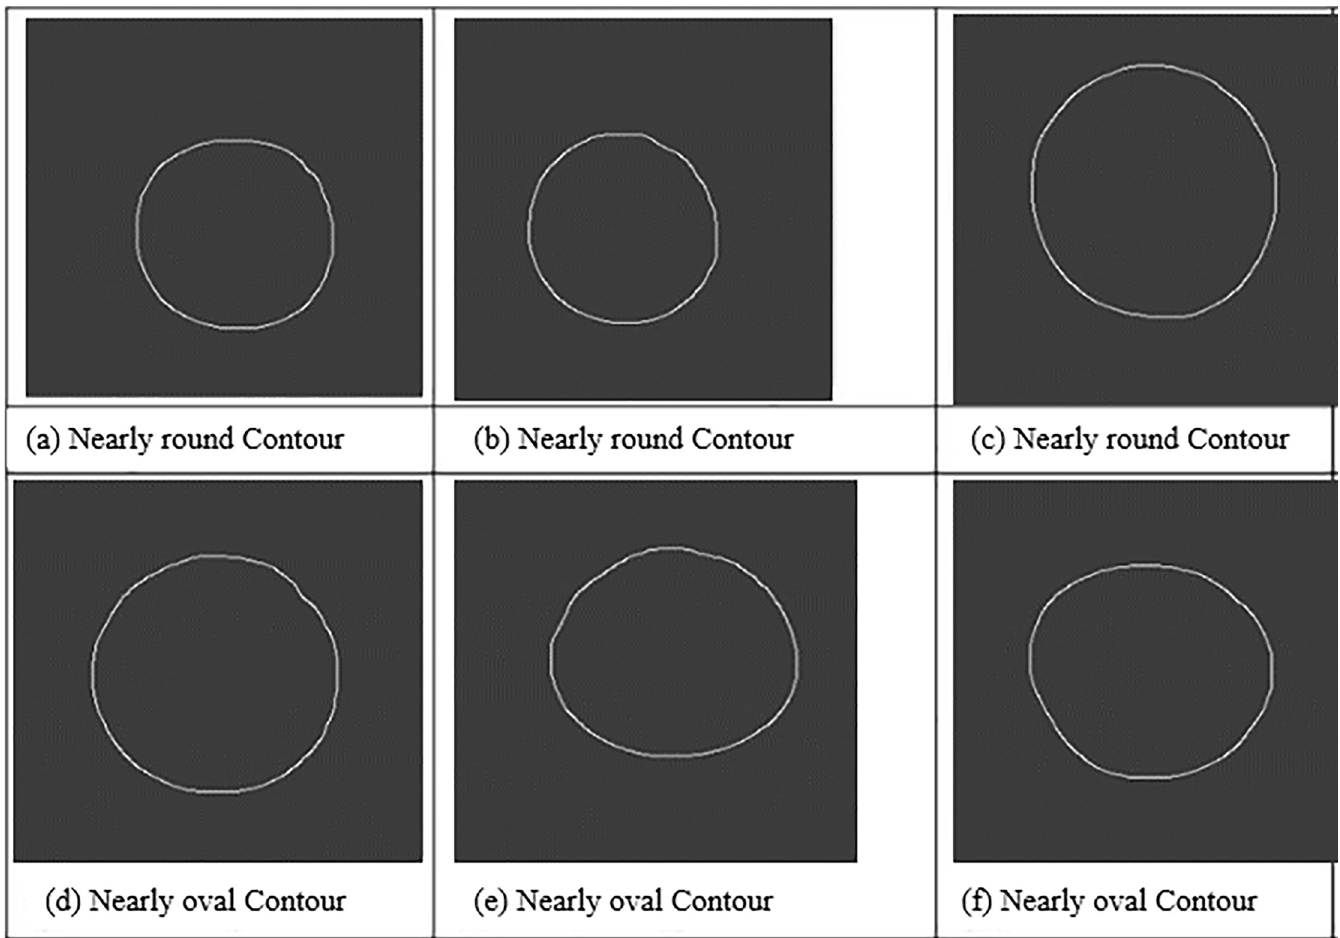
Fig 6. Typical contours of apples. (a)~(c) Nearly round contour (d)~(f) Nearly oval contour.